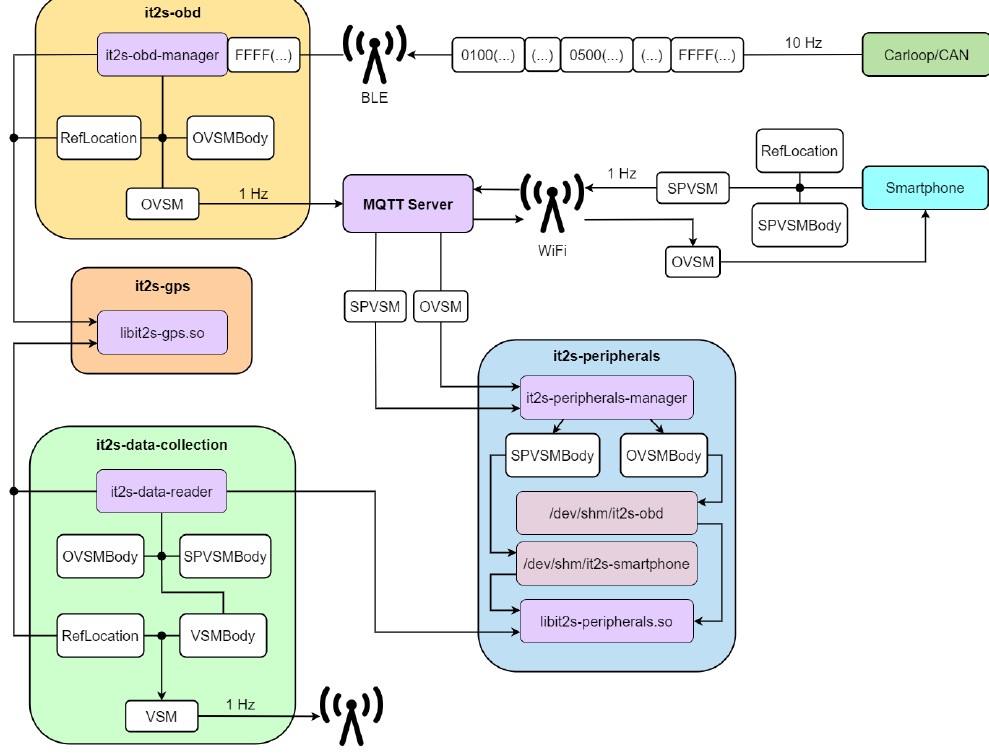
Figure 14. Dataflows between OBU’s services and peripheral devices (OBD-II reader and smart-